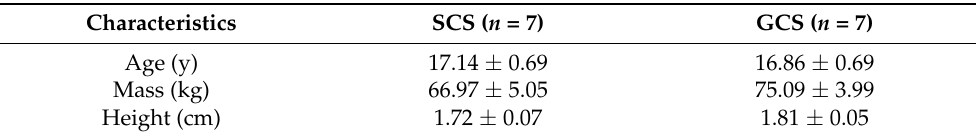
Table 12. Reliability